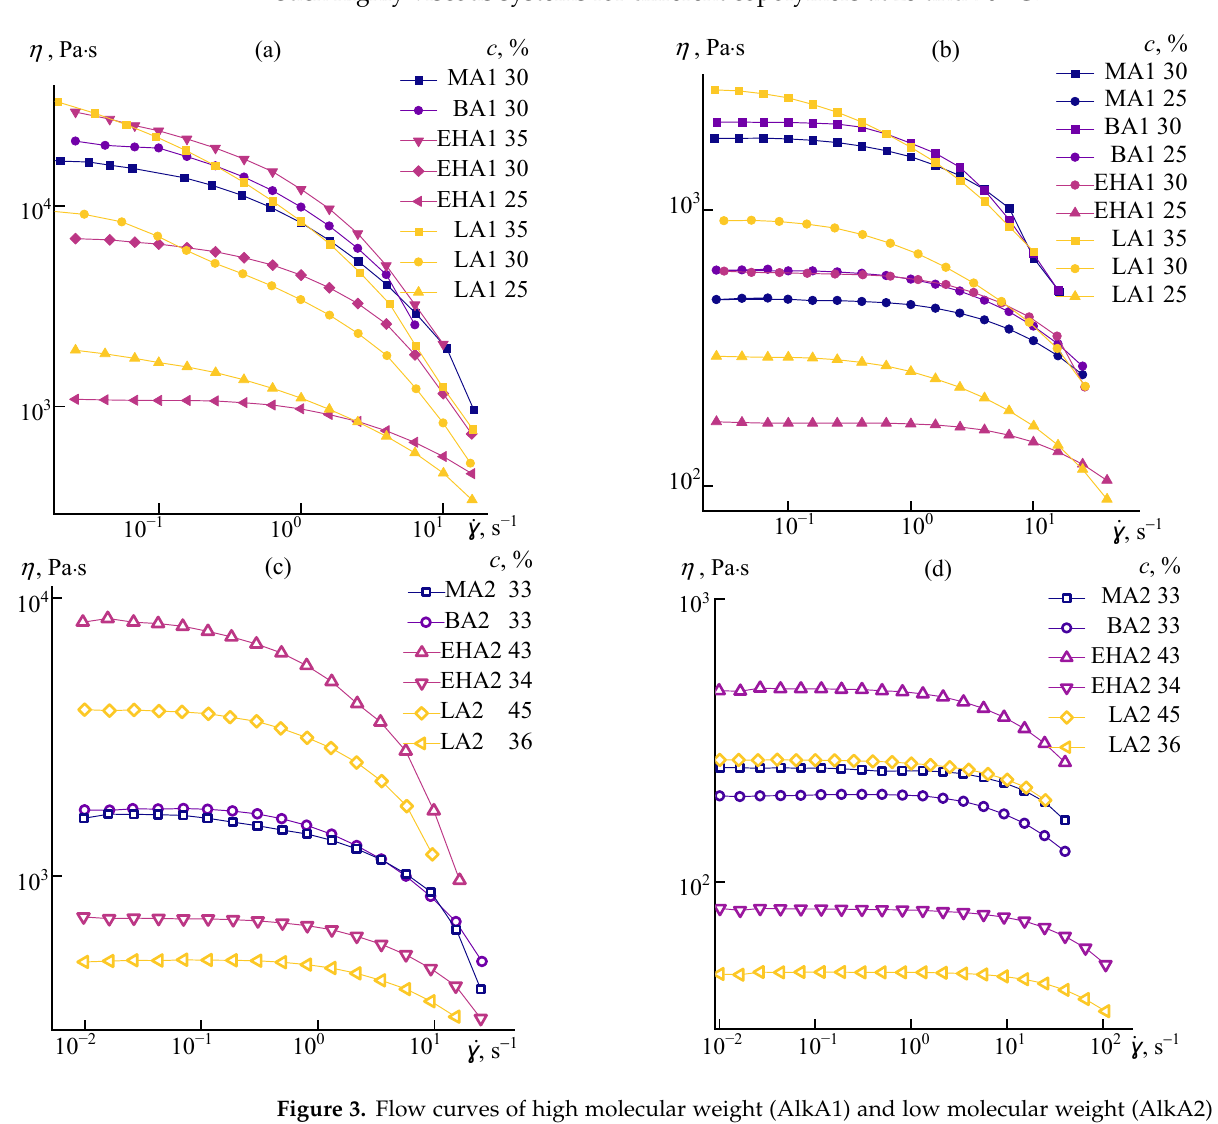
6 of 19 Figure 2. Flow curves of polymer solutions with M w ~150 kg/mol (AlkA1 rank) of various concentra- tions at 25 °C, with various alkyl acrylates: ( a )—methyl acrylate; ( b )—butyl acrylate; ( c )—2-